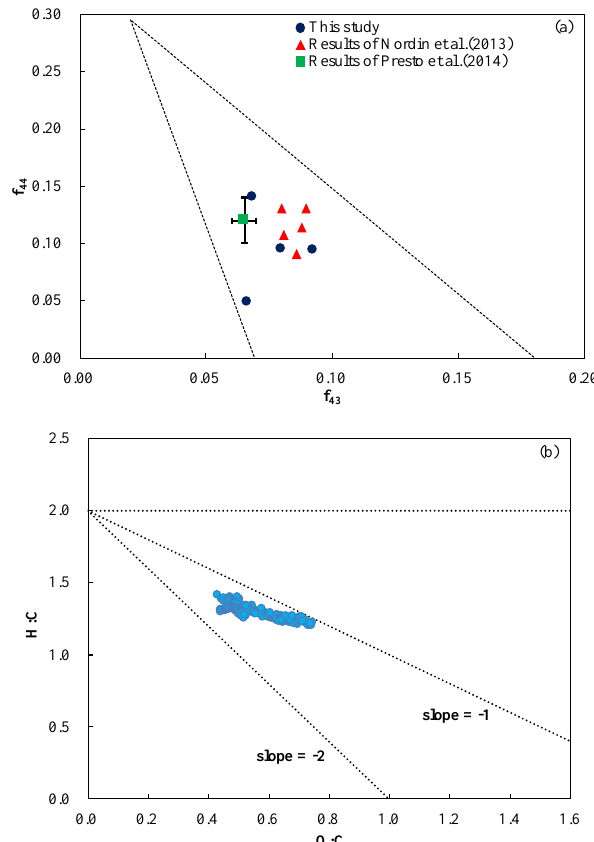
Figure 6. (a) The fractions of total organic signal at m/z 43 ( f 43 ) vs. m/z ( f 44 ) at the end of each experiment together with the tri- angle plot of Ng et al. (2010). The solid square and triangles rep- resent the results of Presto et al. (2014) and Nordin et al. (2013), respectively. The dotted lines define the space where ambient OOA components fall. The ranges of f 44 observed for SV-OOA and LV-OOA components are 0.03–0.11 and 0.13–0.21, respectively. (b) Van Krevelen diagram of SOA from light-duty gasoline vehi- cle exhaust. Dotted lines are to show slopes of 0, − 1 and − 2. AMS data of the experiment 5 were